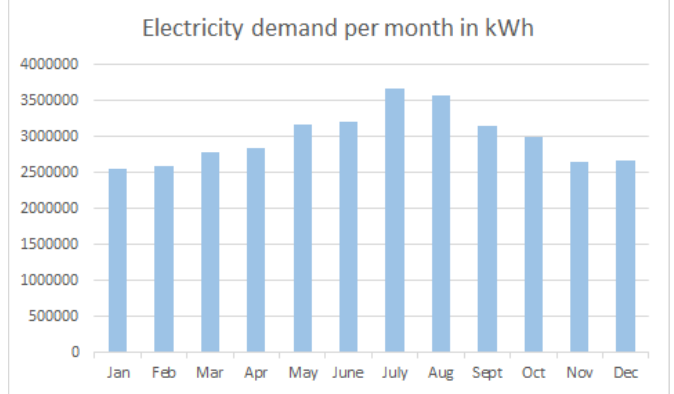
Figure 2. Total electricity demand per